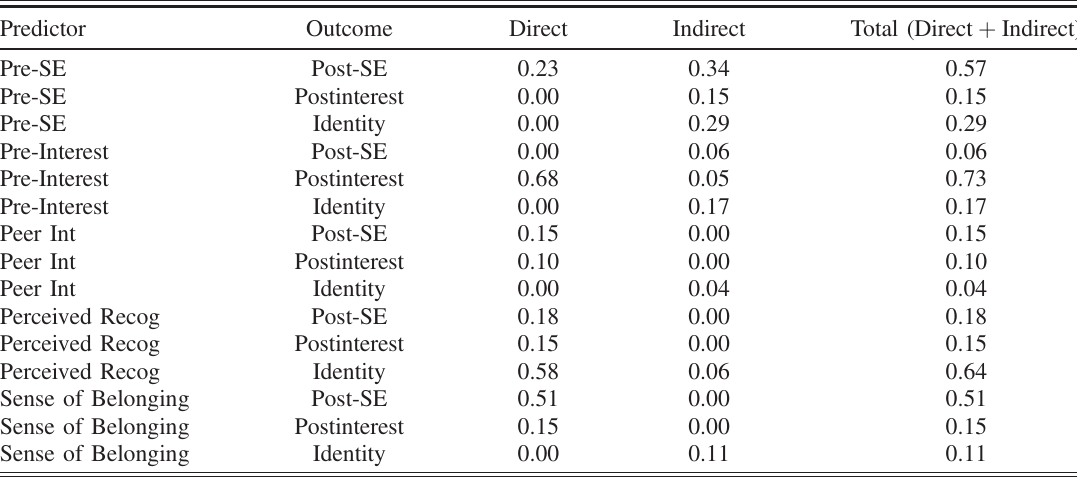
TABLE V. Regression coefficients ( β ) of direct and indirect paths for three outcomes predicted by various predictors in the model which includes perception of learning environment (sense of belonging, peer interaction, and perceived